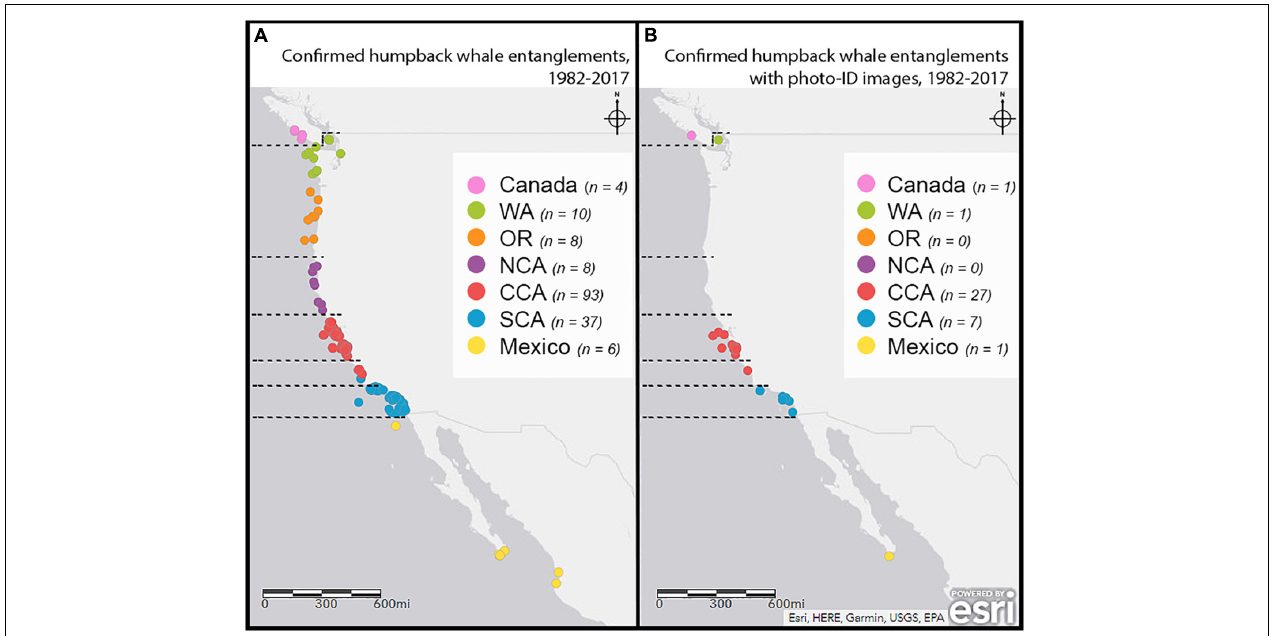
FIGURE 1 | Location of the initial report of confirmed humpback entanglement cases. (A) The distribution of initial reports of confirmed entangled humpback whale cases along the CA-OR-WA region from 1982 to 2017. The data included cases from Canada and Mexico that involved gear from CA, OR, or WA, or gear was removed in US waters. (B) The distribution of initial reports of confirmed entangled humpback whale cases with proper photo-ID images along the CA-OR-WA region from 1982 to 2017. Saez et al. (2020a,b) assigned each case to a “Report Region” (designated by color) based on the initial report location (Canada, WA- Washington, OR-Oregon, NCA-northern California, CCA- central California, SCA- southern California, and Mexico). The dashed horizontal lines designated the subregions used in this study to determine the entanglement reporting region (E.R. region). We used the E.R. regions to select individuals for the control groups and determine if the initial report occurred while the entangled whales were out of their preferred